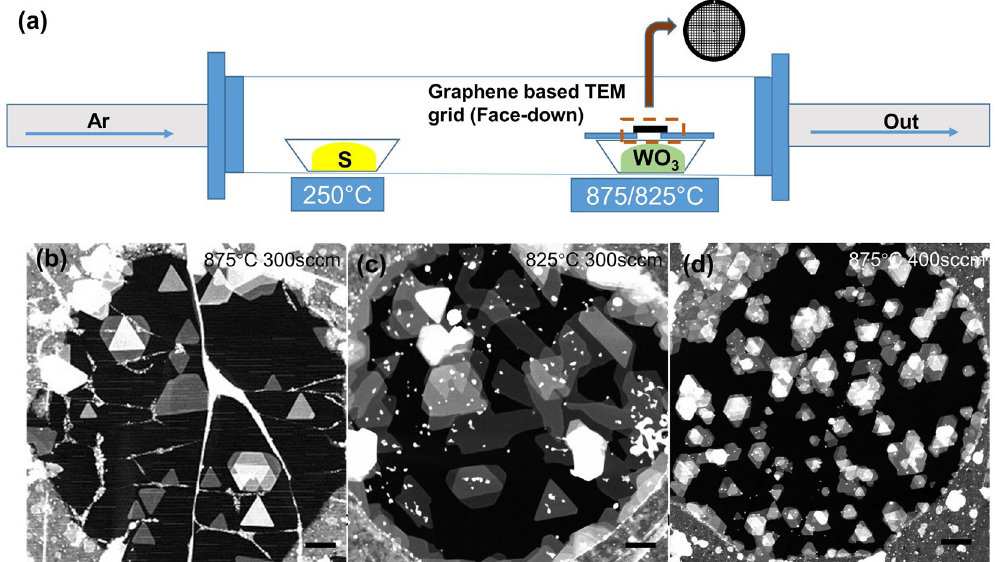
Figure 1. ( a ) Schematic of chemical vapor deposition experimental set-up. Typical low magnification ADF- STEM images of ( b ) MWS-1a, ( c ) MWS-1b and ( d ) MWS-1c. Scale bar: 200